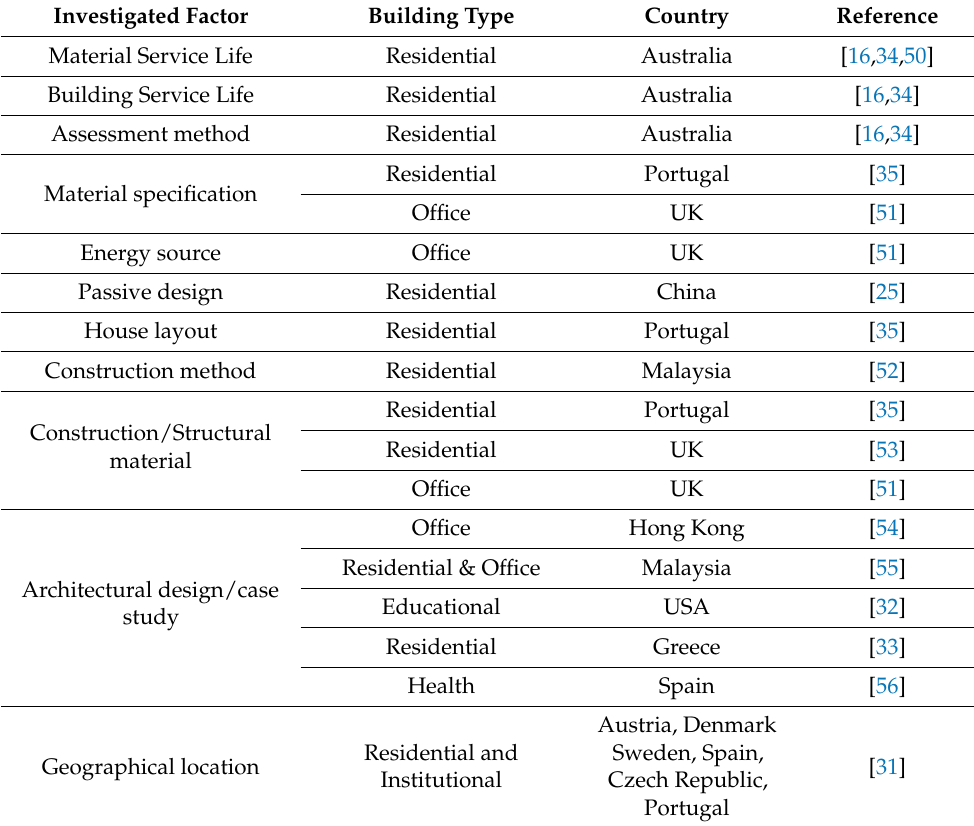
Table 1. A summary of various investigated factors for embodied energy assessment in previous